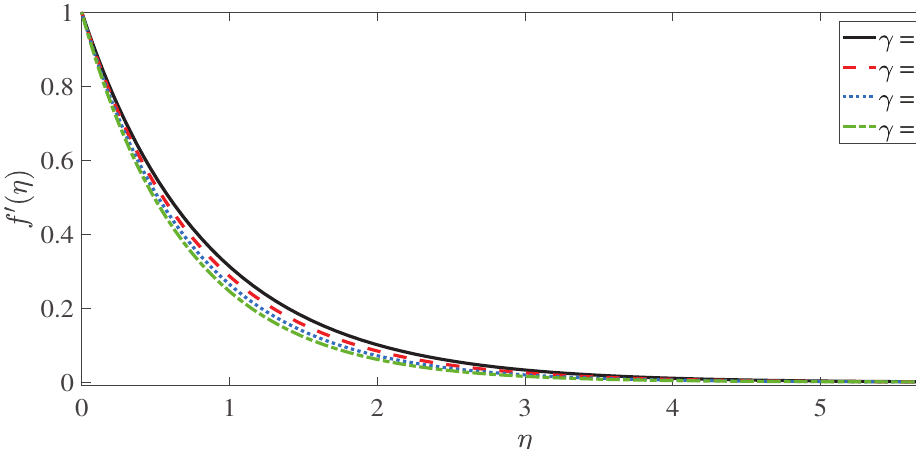
Figure 5. Velocity profile for Permeability parameter γ .